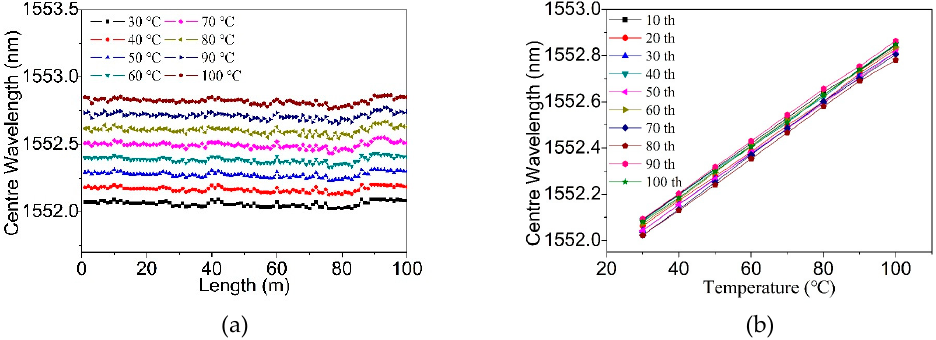
Figure 11. Variation of the center wavelength of ( a ) all FBGs and ( b ) selected FBGs when the temperature increase from 30 °C to 100 °C. increase from 30 ◦ C to 100 ◦